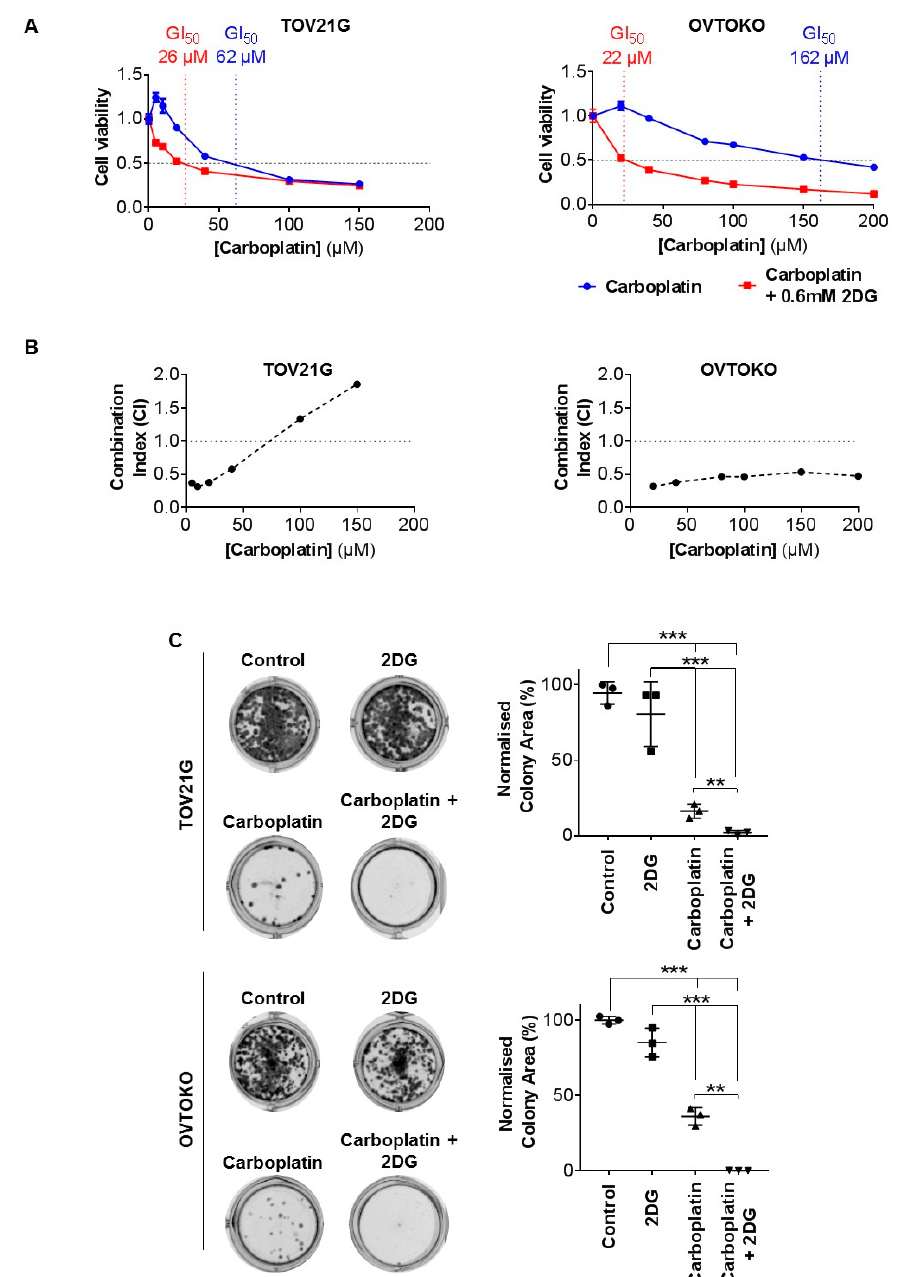
Figure 2. Here, 2DG at a physiologically achievable concentration acts synergistically with carboplatin against OCC cells in vitro. ( A ) TOV21G (left) and OVTOKO (right) cells seeded in 96 well plates overnight were treated for 72 h with carboplatin (TOV21G cells 0–150 µ M; OVTOKO cells 0–200 µ M) or carboplatin combined with 2DG (0.6 mM). Cell viability was quantified and graphed to determine GI 50 (blue, carboplatin; red, carboplatin combined with 2DG). ( B ) Synergism was assessed in TOV21G (left) and OVTOKO (right) cells using the Chou-Talalay Combination Index (CI) method. CI < 1 indicated synergism. ( C ) Colony formation assays were performed on TOV21G (upper) and OVTOKO (lower) cells plated overnight in six well plates then treated with phosphate buffer saline (PBS), 2DG (0.6 mM), carboplatin (GI 50 concentration determined in A), or carboplatin combined with